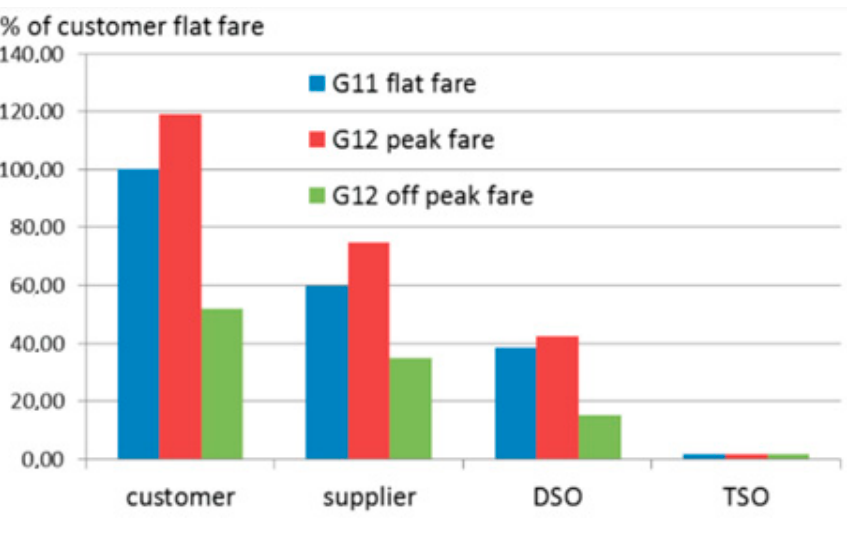
Figure 2. Time of Use pricing